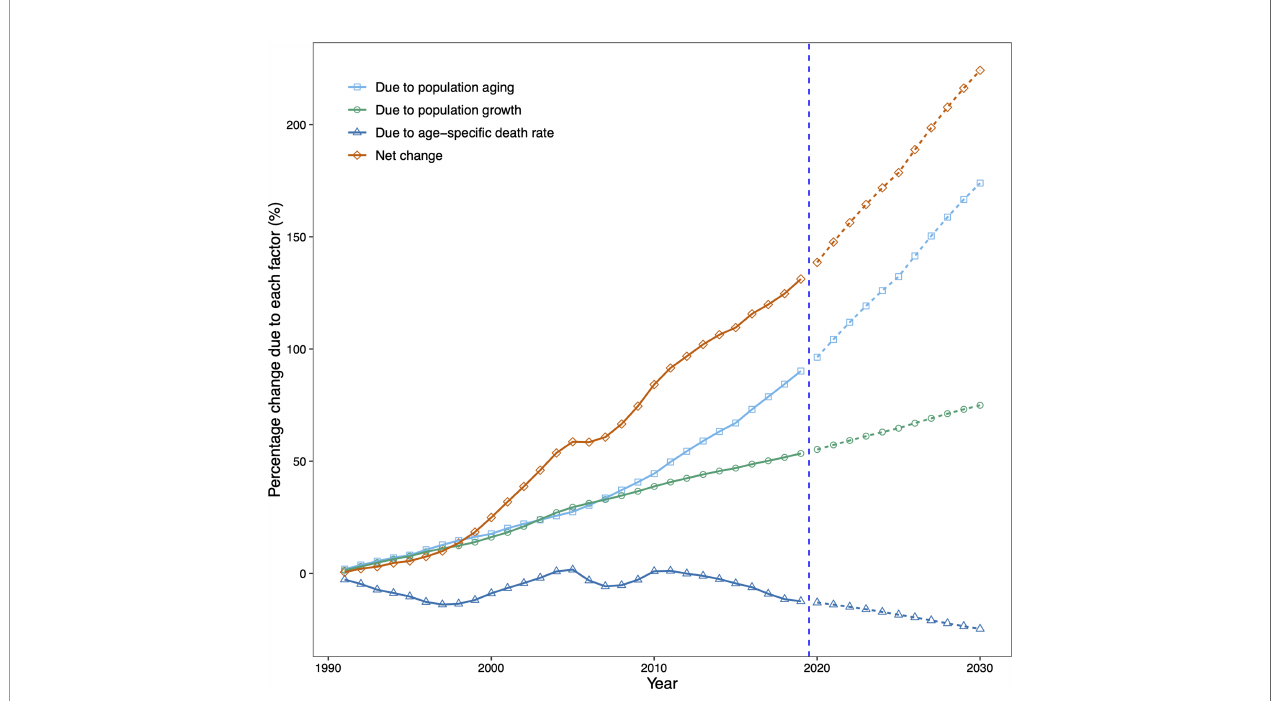
FIGURE 6 | Contribution of changes in population aging, population growth, and age-speci fi c type 2 diabetic kidney disease (DKD) death rate to changes in number of DKD deaths from 1991 to 2030 for both sexes in China, using 1990 as the reference year. Data in the right of the blue dashed line were the decomposition based on the projected data. DKD, type 2 diabetic kidney